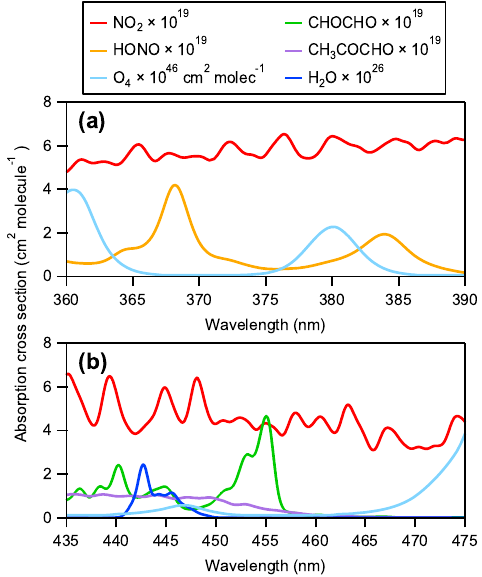
Figure 2. Convolved literature absorption cross sections shown for the ACES wavelength range for (a) Ch 368: NO 2 , HONO, and O 4 ; and (b) Ch 455: NO 2 , CHOCHO, CH 3 COCHO, H 2 O, and O 4 .